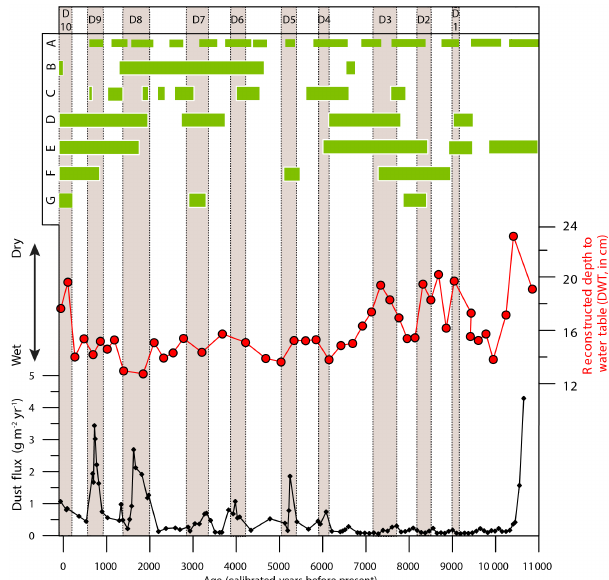
Figure 7. Comparison of dust events and bog wetness as recon- structed from the Mohos record to regional hydroclimate recon- structions. Data presented via green bars is drought, dry, and/or low lake periods from the following publications. A: Magny, 2004; B: Cristea et al., 2013; C: Gałka et al., 2016; D: Magyari et al., 2013l; E: Buczkó et al., 2013; F: Magyari et al., 2009; and G: Schnitchen et al., 2006. These are presented alongside the Mohos testate-amoeba- derived depth to water table record and Ti-derived dust